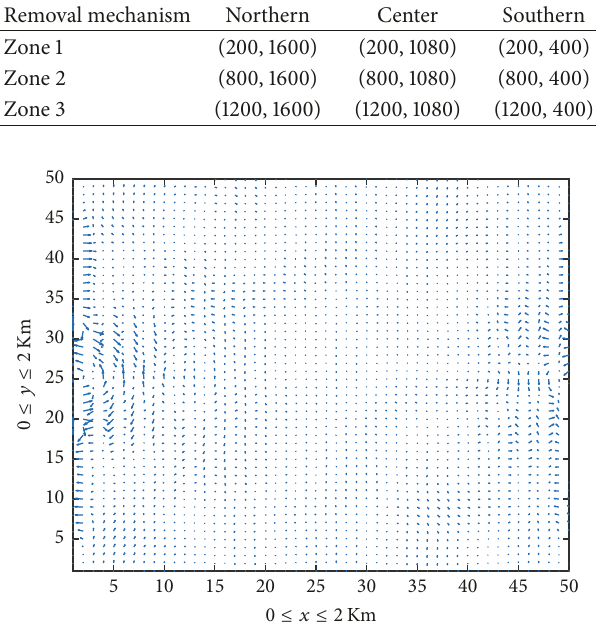
Figure 5: Approximated water velocity in an opened-closed reser-